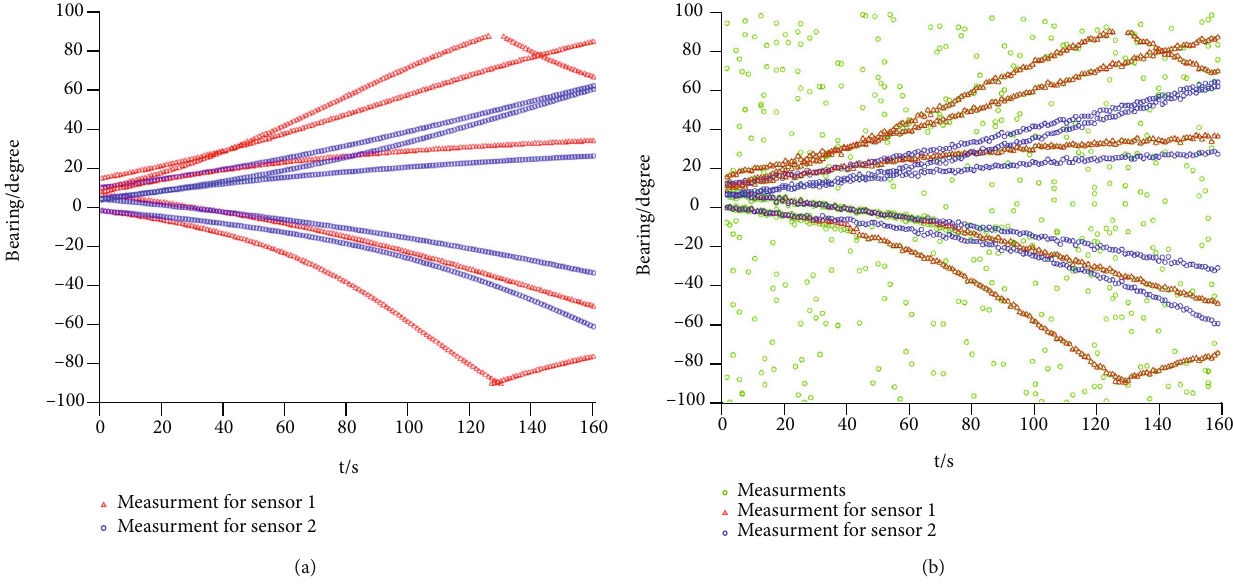
Figure 4: Bearing measurements for two static passive observers: (a) the true bearing measurements without clutter; (b) synthetic bearing measurements with clutter.